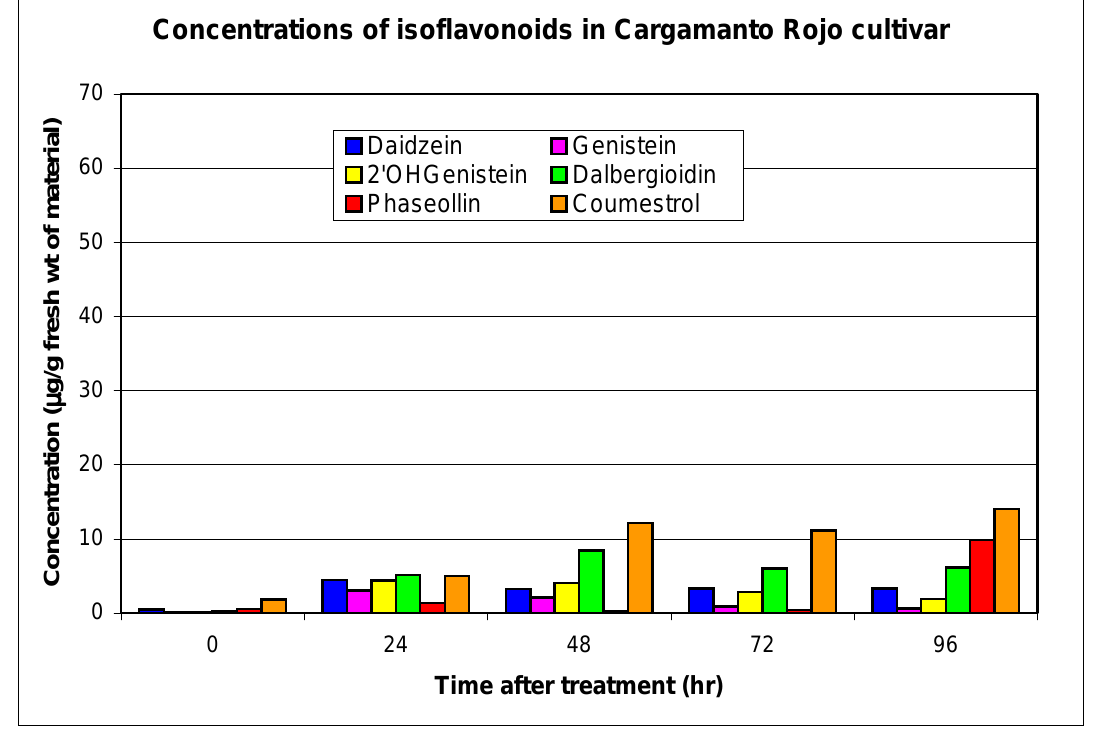
Concentrations of isoflavonoids in Cargamanto Rojo cultivar